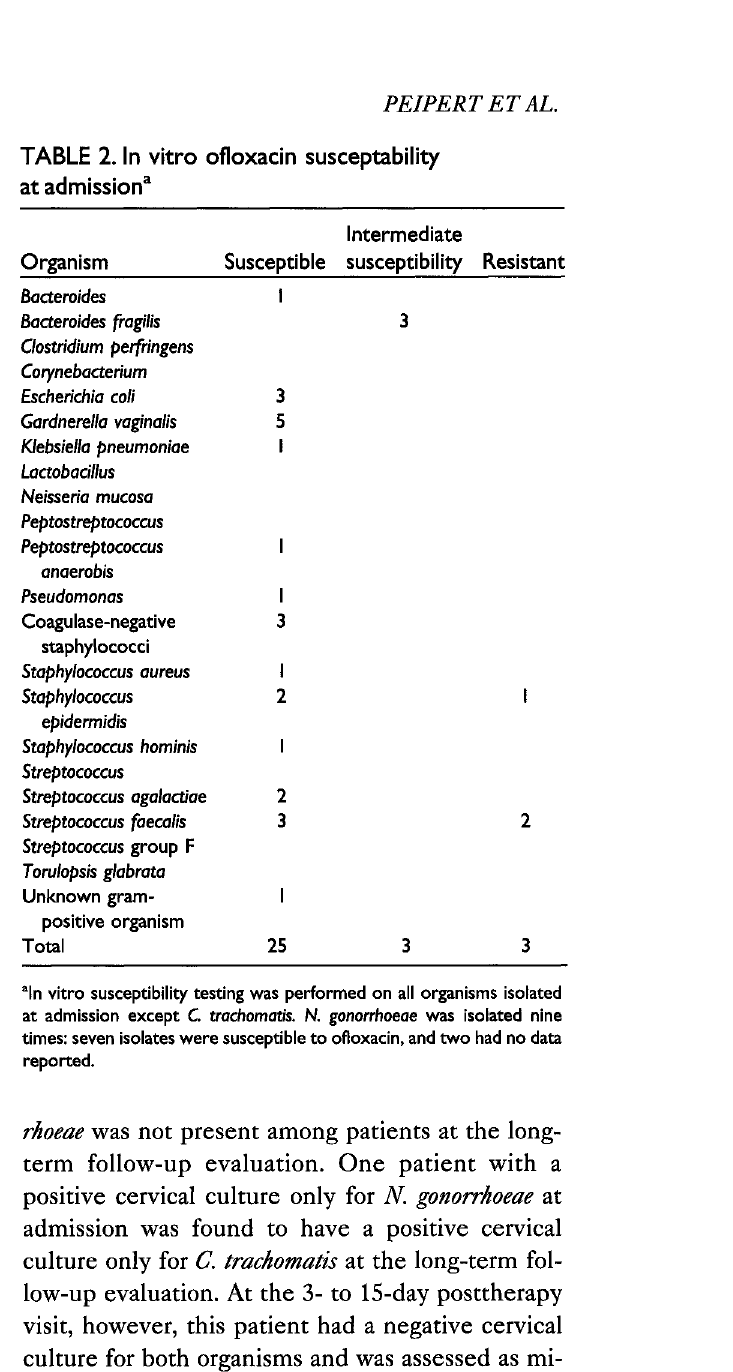
TABLE 2. In vitro ofloxacin